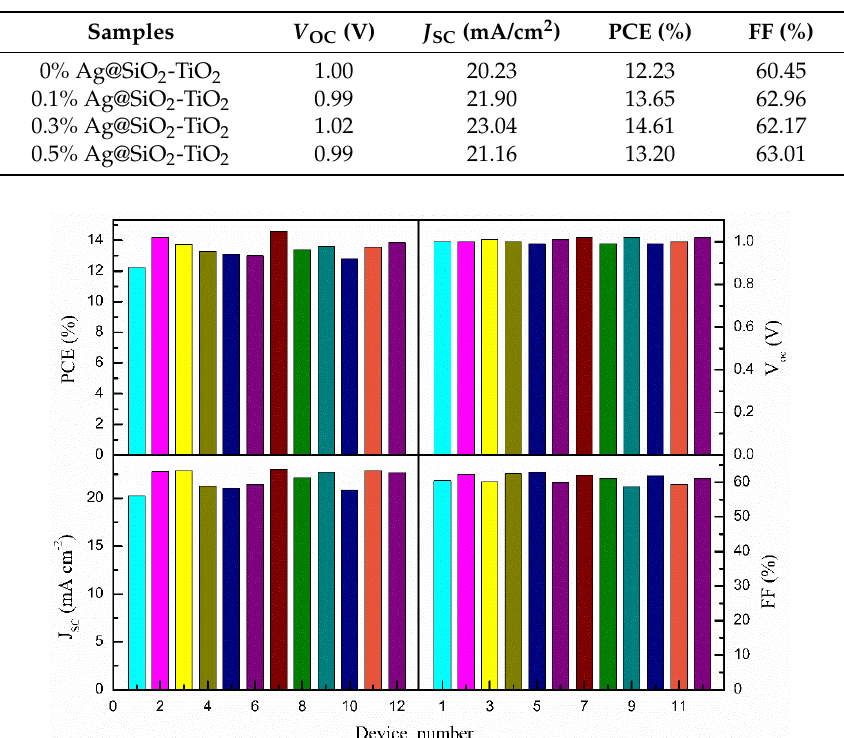
Figure 7. Histograms of photovoltaic parameters for 12 devices (the same batch of samples) based on